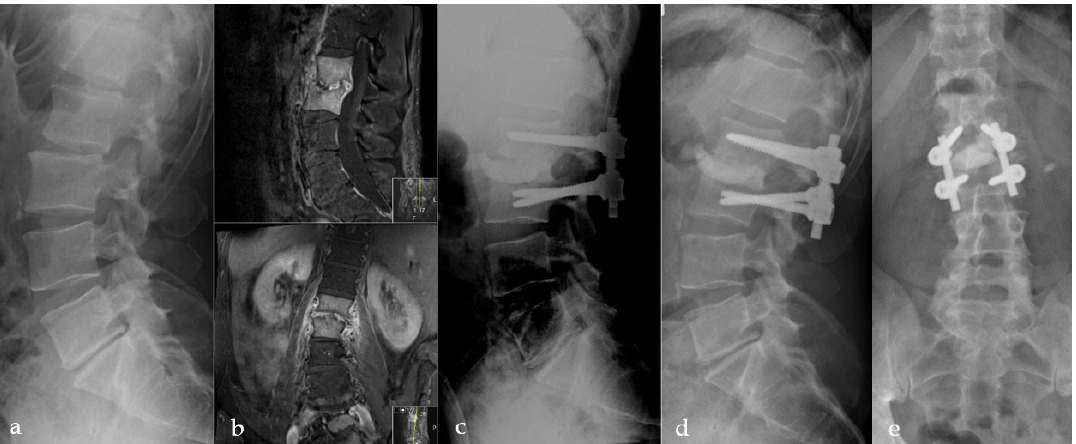
Figure 4. Initial X-ray shows a retrolisthesis L2/3 with mild segmental degeneration in a sixty-two- year-old male patient ( a ). Follow-up MRI due to persistent pain six weeks later shows pyogenic spondylodiscitis in L2/3 with progressive bony destruction ( b ). Directly postoperative ( c ) and 12 months ( d), ( e ) postoperative a.p. and lateral radiographs with anterior PMMA leakage, bone re- generation, and stable implants.